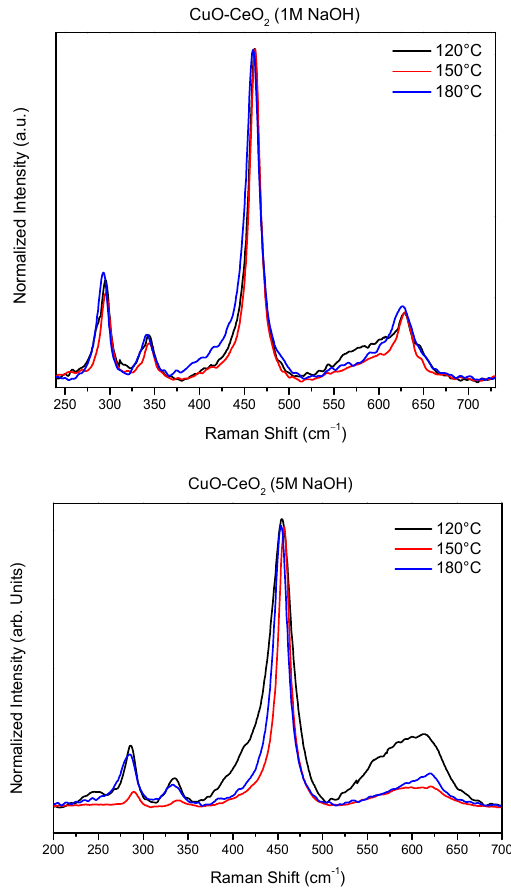
Figure 6. Raman spectra of the CuOCeO 2 samples.